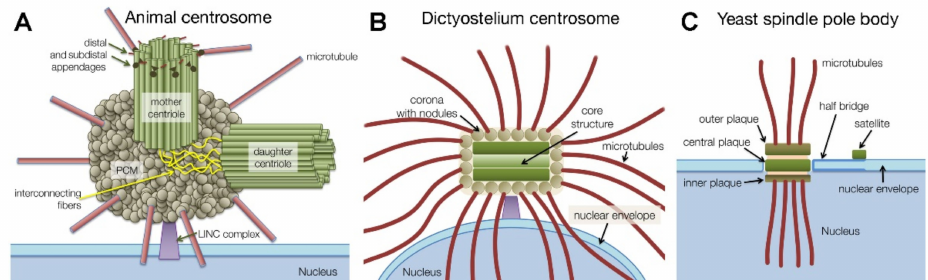
Figure 1. Schematic comparison of centrosomal structures in animals ( A ), Dictyostelium ( B ), and budding yeast ( C ). Functionally or topologically related structures are drawn in corresponding colors. Taken from